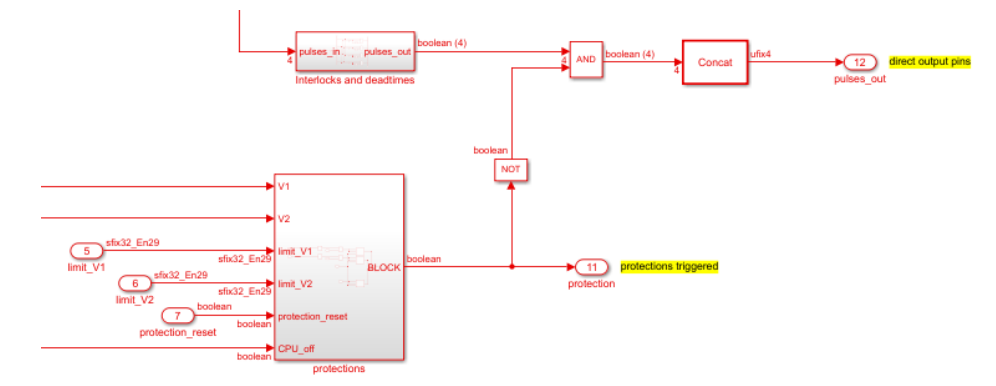
Figure 26. Protections block and respective pulse blocking mechanism found in the demo